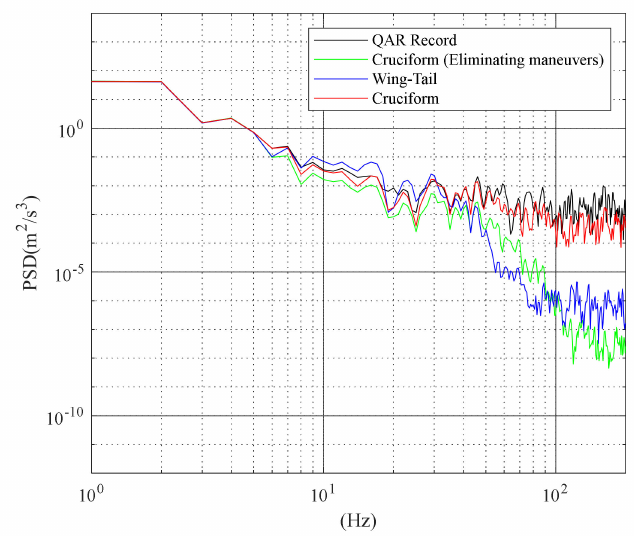
Figure 9. Comparisons of the acceleration